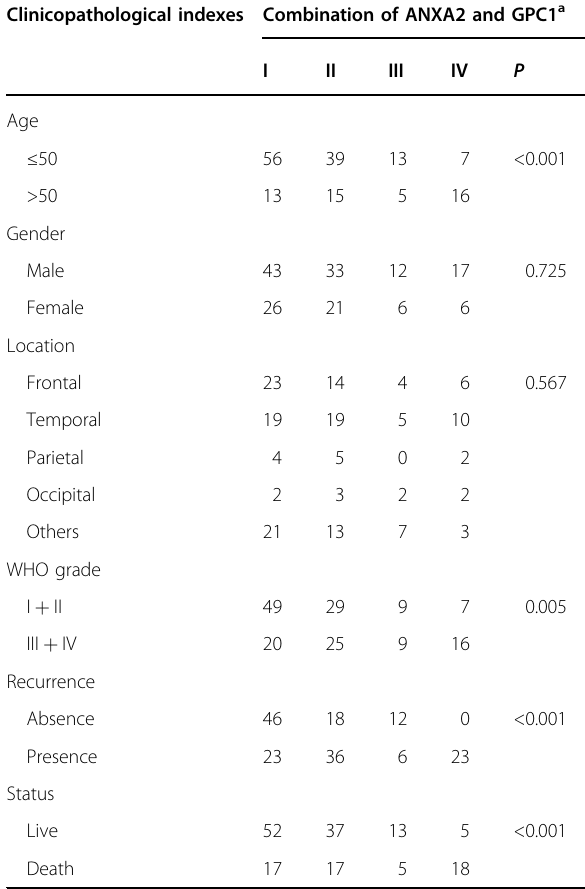
Table 1 Correlation between the factors and clinicopathologic characteristics in glioma ( n = 164). Clinicopathological indexes Combination of ANXA2 and GPC1